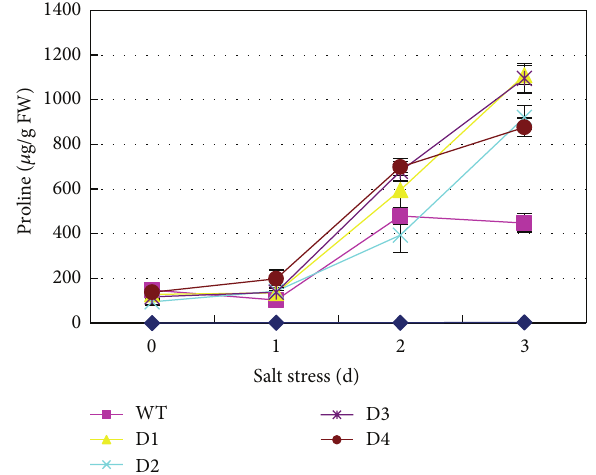
Figure 2: Proline content in WT plants and SbPIP1 gene transgenic lines. D1, D2, D3, and D4 represent the transgenic lines D1, D2, D3, and D4, respectively; WT represents the untransformed wheat variety Ningmai